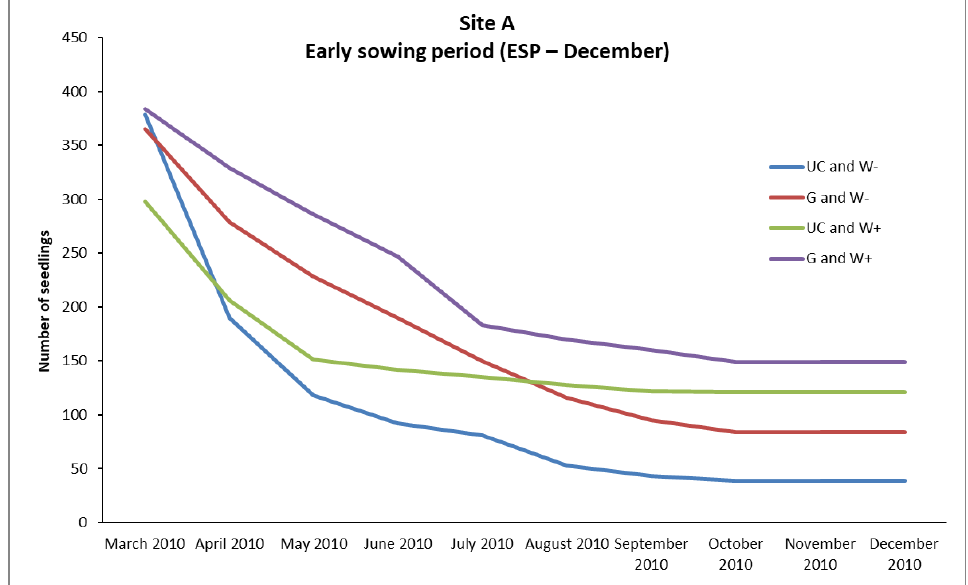
Figure 5. Monthly seedling survival (number of living seedlings) of the December sowing (ESP) in the plots of each combination of the two factor levels in site A for the period March 2010–December 2010 (the March 2010 record shows the number of germinated seeds).